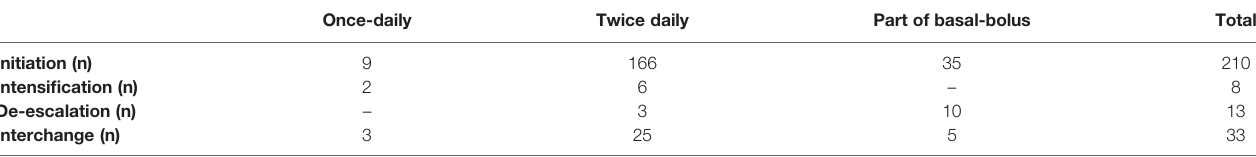
TABLE 3 | Insulin Regimen and Frequency in Type 2 Diabetes Patients Under IDegAsp Treatment. Once-daily Twice daily Part of basal-bolus